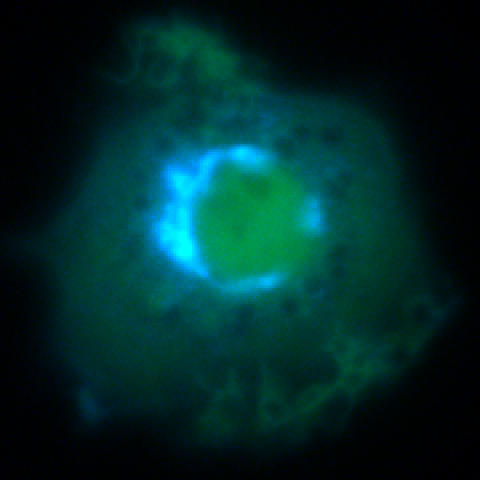
Fluorescent proteins localize the guanosine 5'-triphosphate hydrolase ARF in the Golgi apparatus of a living macrophage. FRET studies revealed ARF activation in the Golgi and in the formation of phagosomes.